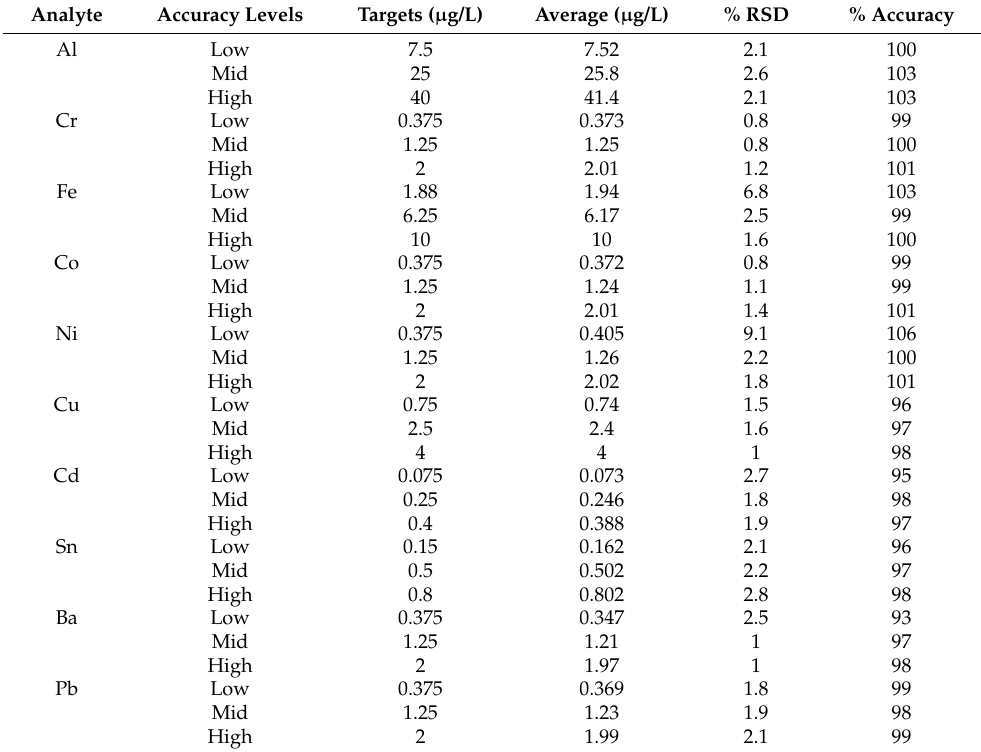
Table 3. Accuracy results for spiked oil matrix.